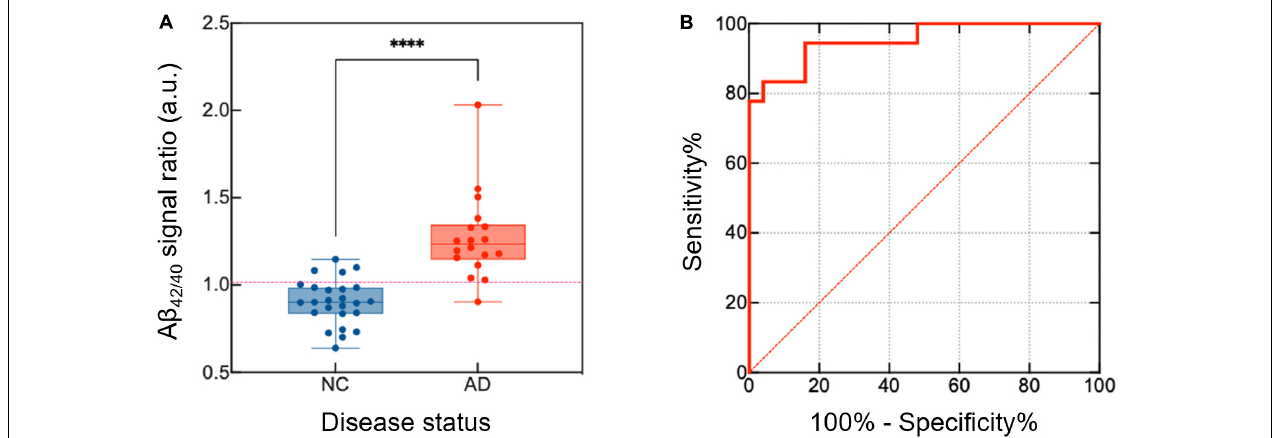
FIGURE 2 | Differentiation of the NC and AD groups based on the analysis of plasma A β 42 / 40 levels. To distinguish between the NC and AD groups, the relative signal level of A β 42 and A β 40 was calculated. (A) The ratio of the signal between the A β 42 and A β 40 was higher in the AD group than in the NC group. (B) A high AUC value was calculated using the ROC (AUC = 0.952, 95% CI, 0.892–1.000). p -values are indicated with asterisks: **** p < 0.0001. NC, normal control; AD, Alzheimer’s disease; A β , amyloid- β ; AUC, area under the curve; ROC, receiver operating curve; CI, confidence interval.